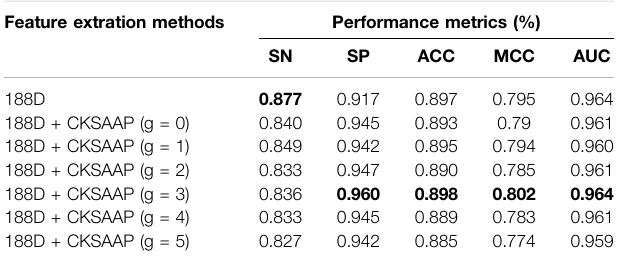
TABLE 6 | Classi fi cation results of different under-sampling methods on the train